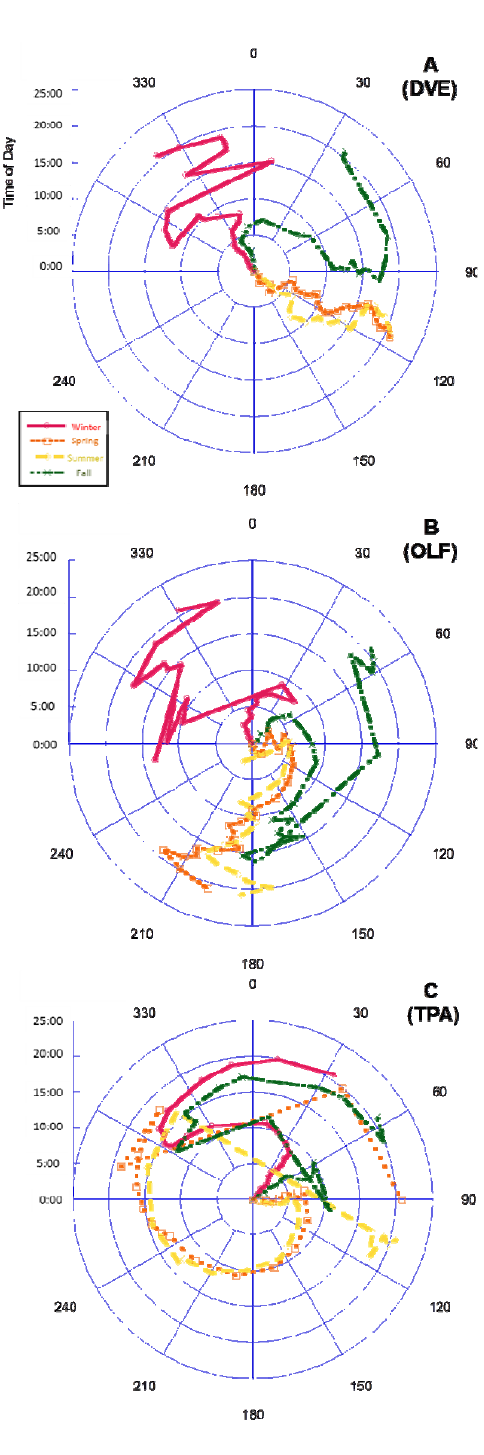
Fig. 2. Prevailing wind direction over the course of 24h for each season for (A) DVE, (B) OLF and (C)